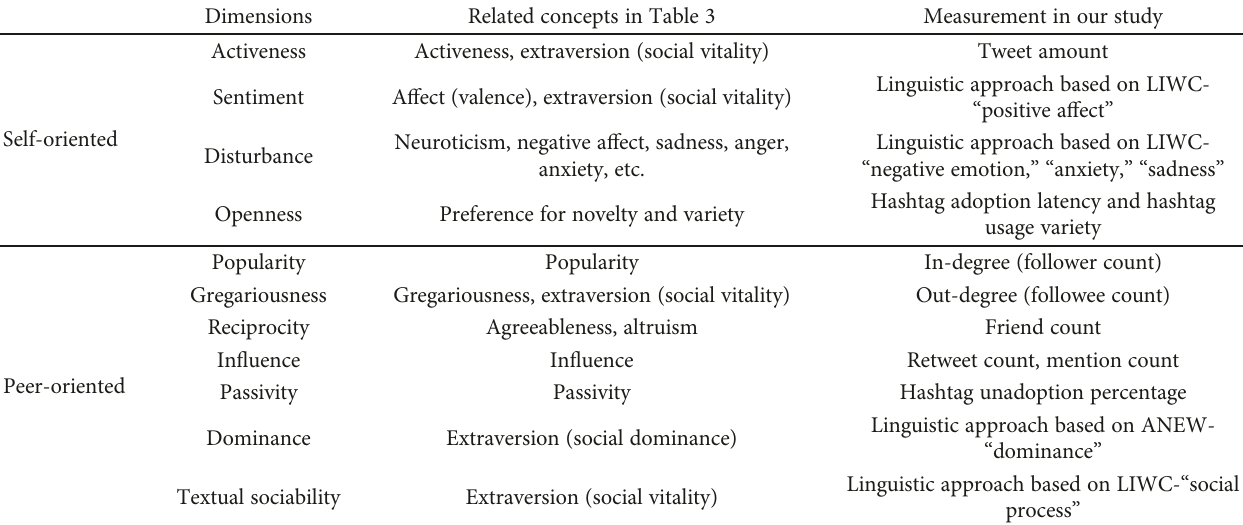
Table 1: User-oriented behavior interior